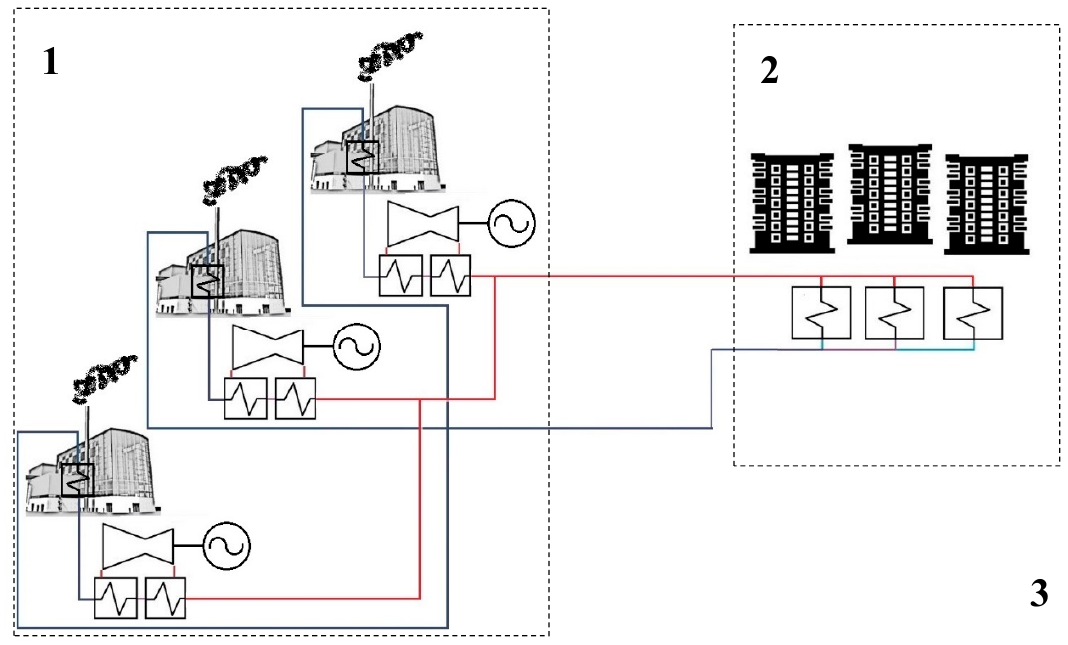
Figure 2. Illustration of a traditional district heating system: (1) Combined heat and power (CHP) power plants; (2) traditional heat load—district heat (DH) substations in parallel; (3) studied system with boundary connections to the fuel and electricity market.